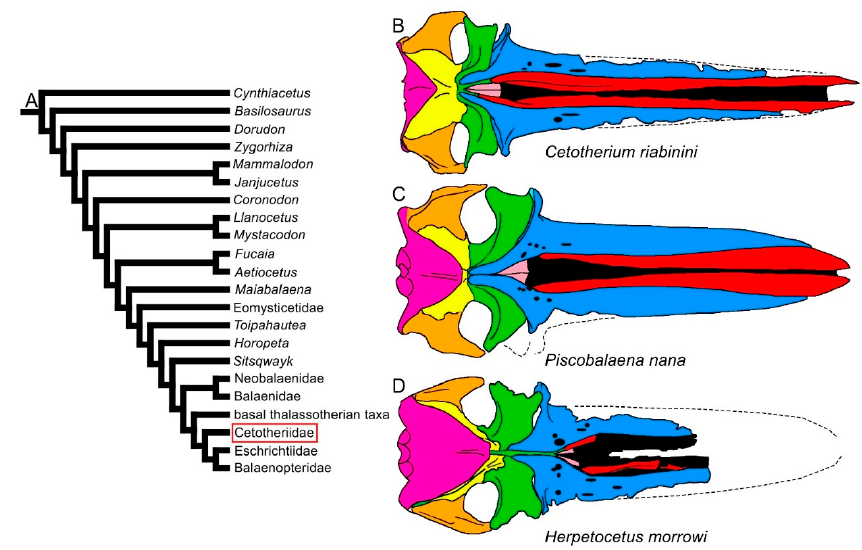
Figure 13. Diversity of balaenomorph mysticete skulls in dorsal view: Cetotheriidae. ( A ) Phylogenetic relationships among mysticetes showing the position of Cetotheriidae. ( B ) Skull of Cetotherium riabinini . ( C ) Skull of Piscobalaena nana . ( D ) Skull of Herpetocetus morrowi . Not to scale. The skulls are represented as if they shared the same condylobasal length.